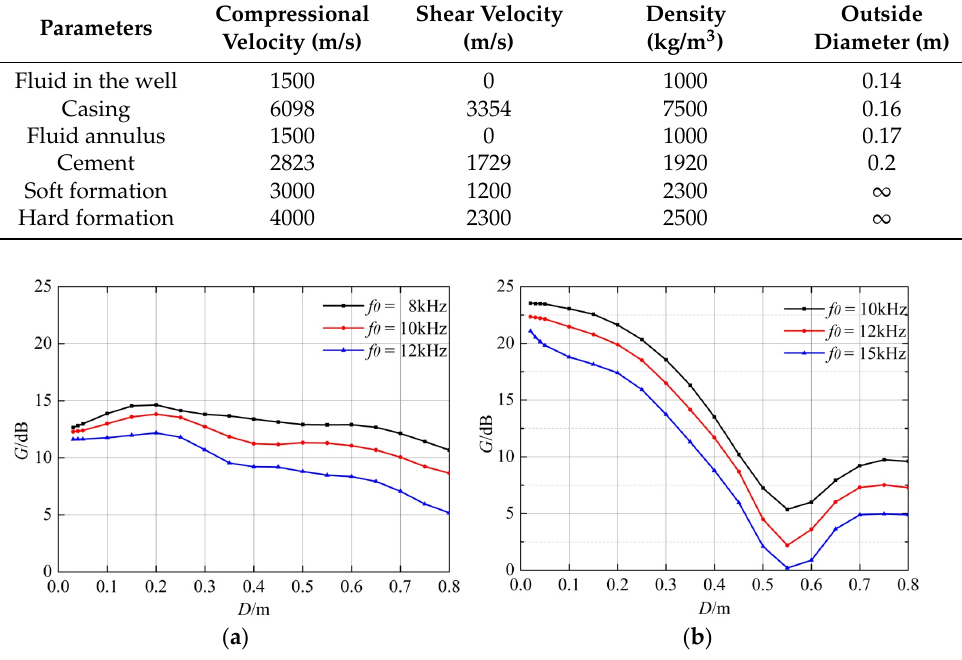
Figure 3. Relationship between the suppression effect of the casing wave and the span distance for a hard formation ( a ) and a soft formation ( b ).